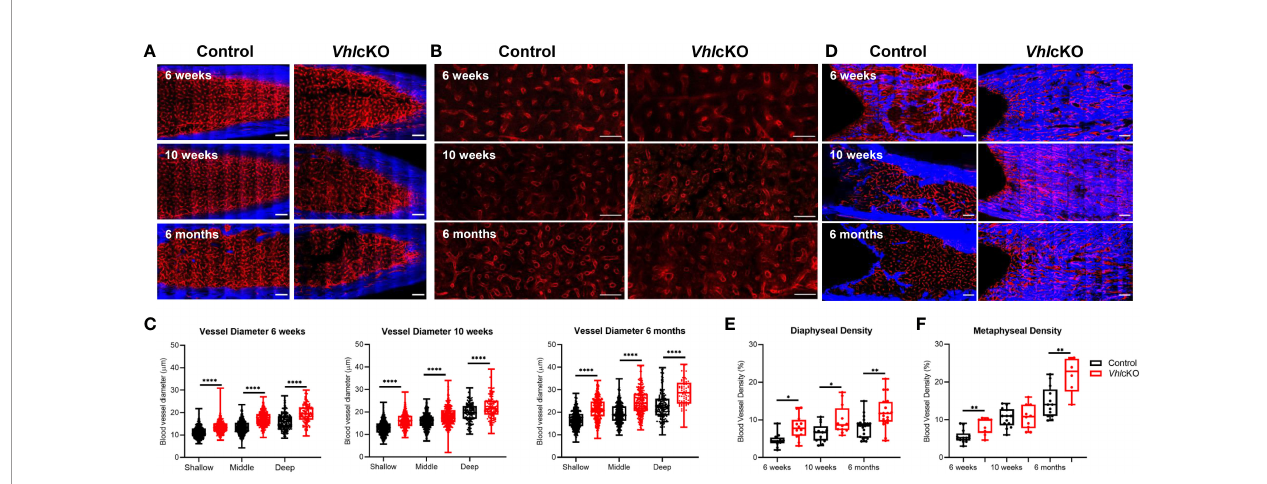
FIGURE 6 | | Ex vivo two-photon imaging of long bones in Vhl cKO and controls. (A) Representative macroscopic images of the femur diaphyseal BM (scale bars: ~200 m m), (B) magni fi ed z-stacks (scale bars: ~100 m m), and (C) statistical analysis after uDISCO clearing show an increase in the Vhl cKO vascular diameter relative to the controls; (D) ex vivo images of femur metaphyseal BM after max intensity projection reveal bone replacement and vascular alteration in Vhl cKO; (E, F) quanti fi cation of the metaphyseal and diaphyseal vascular density (scale bars: ~200 m m). Red: blood vessels (labeled with Alexa647 conjugated antibodies against CD31, CD144, and Sca-1), Blue: bone (SHG: Second harmonic generation). *p<0.05, **p<0.01, ****p<0.0001, two-tailed Student ’ s t-test.